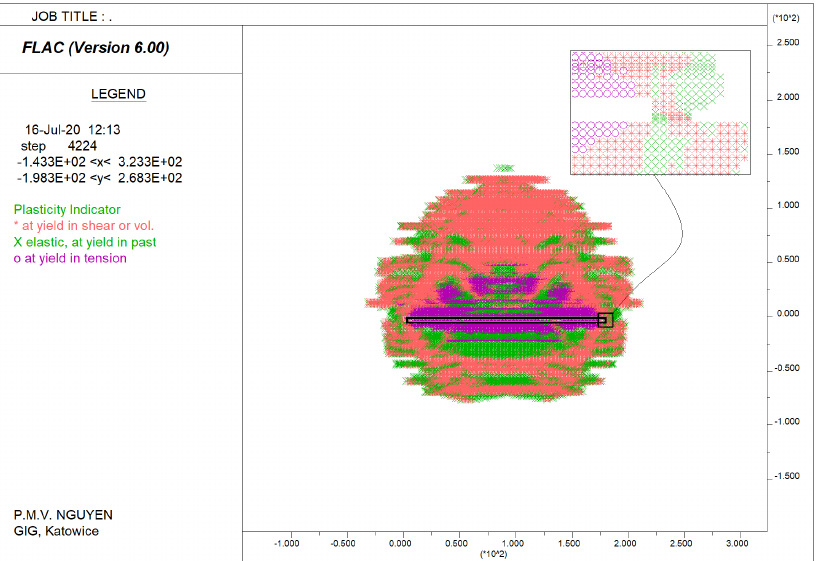
Figure 3. An example of a plasticity indicator map defining the destressing zone around the longwall panel.